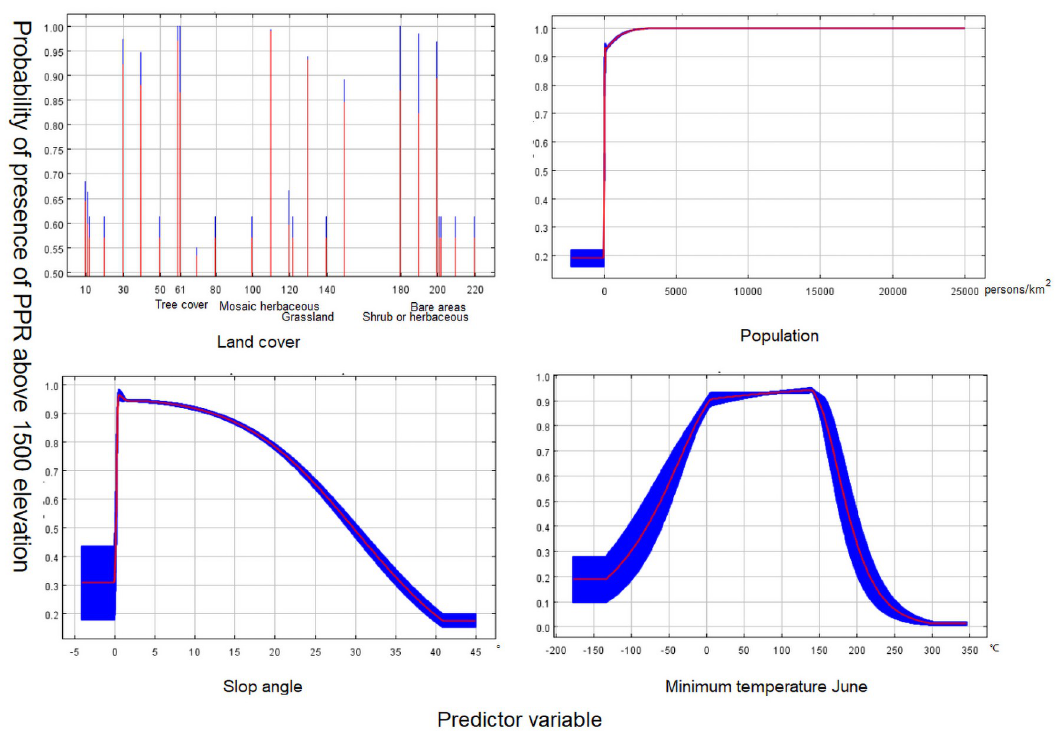
Fig 2. The response curves of the model ( � 1500 m). The curves show the mean response (red) and the mean standard deviation (blue).